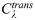
Routing strategies for privileged nodes.Network average values of Cλtrans (left panel) and Cλinfo (middle panel) as a function of λ (node medians across all subjects) for 22, 55, 110, and 165 privileged nodes (corresponding to 10%, 25%, 50% and 75% of the network’s nodes) that are selected according to betweenness centrality ranking (yellow line), strength ranking (purple line), shortest-path-based closeness centrality (green line), and random-walk-based closeness centrality (blue line). For comparison purposes, we also show cost measures for randomly sampled nodes (red line represents average across 500 samples). The dotted lines show Cλtrans and Cλinfo, respectively, for the case in which all nodes’ routing strategies are biased (i.e. 100% privileged nodes). Right panel shows node stretch distributions for the different sets of privileged nodes and centrality rankings. Black markers indicate the median of the distributions.